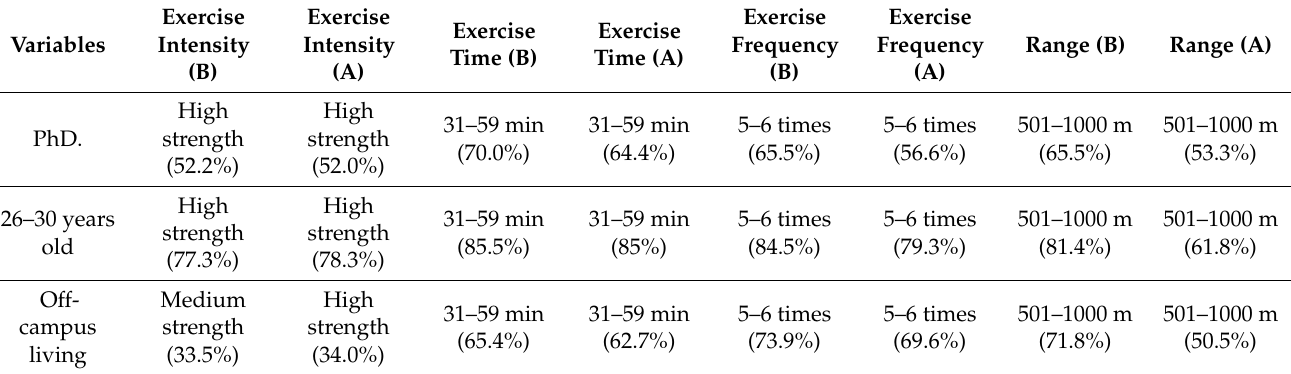
Figure 2. The exercise motivation intention factors with the highest average health belief scores. Table 5. Summaries of physical exercise behaviors among those with strong health beliefs before and after the